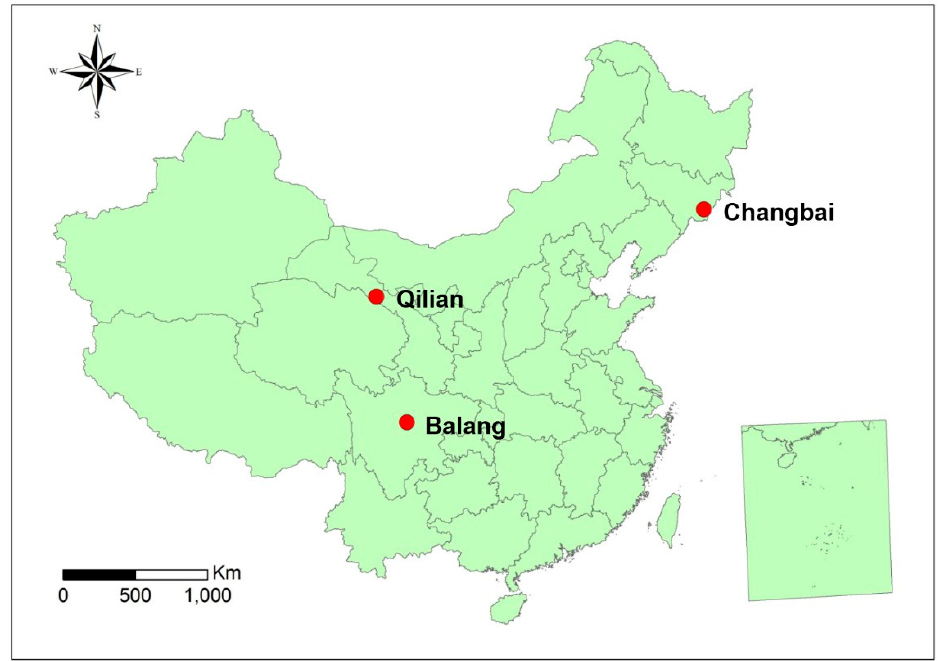
Figure 1. Location of three sampling sites of Balang Mt. (subtropical), Qilian Mt. (dry-temperate) and Changbai Mt. (wet-temperate).